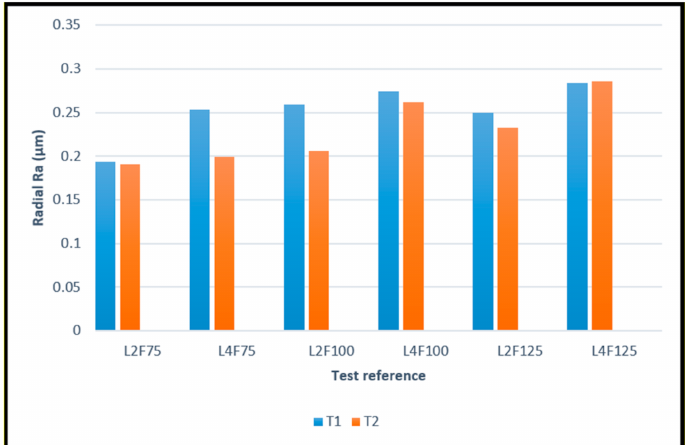
Figure 2. Average values of Ra, measured in the radial direction, produced by T1 and T2 tools for all the different test